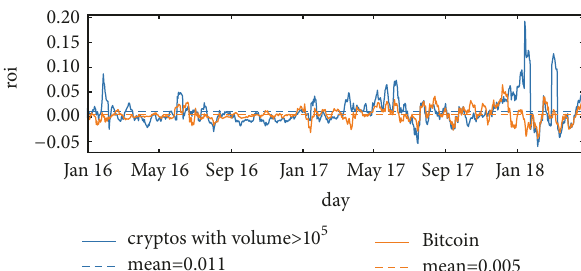
Figure 2: Return on investment over time. The daily return on investment for Bitcoin (orange line) and the average for currencies with volume larger than 𝑉 𝑚𝑖𝑛 = 10 5 USD (blue line). Their average value across time (dashed lines) is larger than 0 . For visualization purposes, curves are averaged over a rolling window of 10 days.